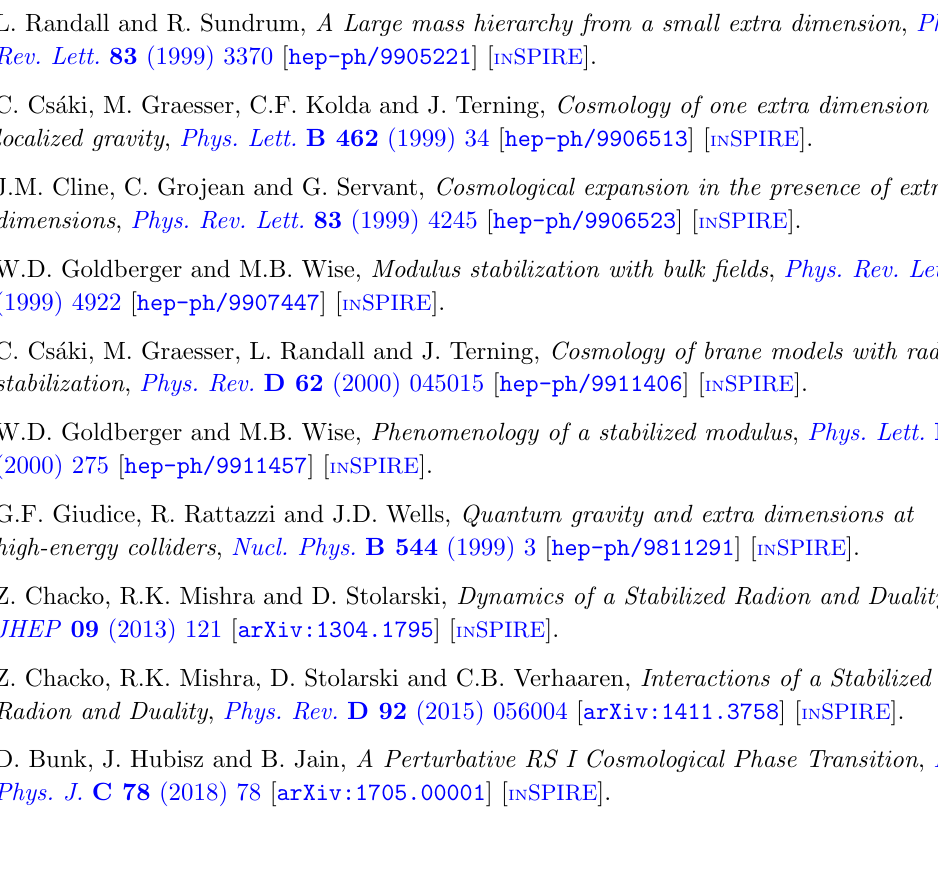
Figure 13. Plots of x = v 2 g 2 (cid:15) = 10 (cid:0) 13